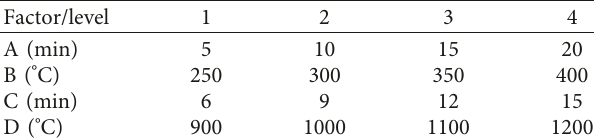
Table 4: Presintering experimental